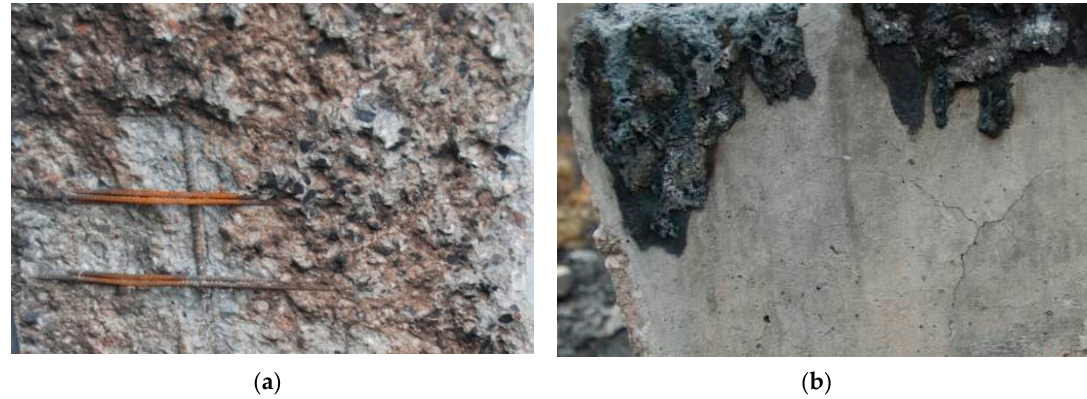
Figure 1. ( a ) Split and ( b ) cracking of concrete cover after firefighting.